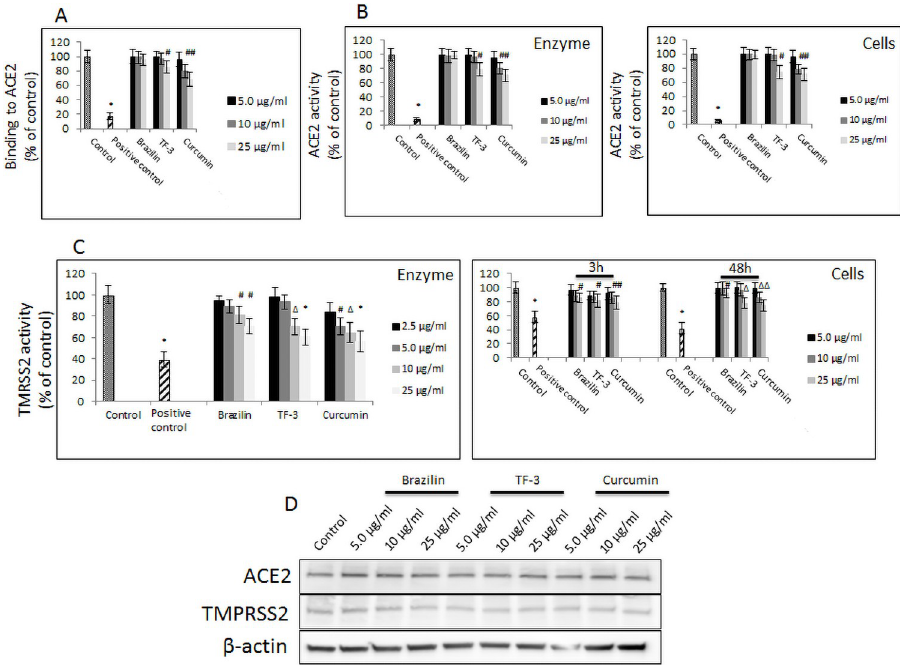
Fig 5. Effects of selected polyphenols on cellular membrane associated proteases. (A) Binding of indicated polyphenols at different concentrations to hACE2 receptor. Data are presented as % of control ± SD; control– 0.025% DMSO, positive control– 50% DMSO. (B) Activity of recombinant hACE2 upon treatment with indicated polyphenols at different concentrations. (left panel). Activity of cellular hACE2 upon treatment with indicated polyphenols at different concentrations. (right panel). Data are presented as % of control ± SD; � p � 0.001. Control– 0.025% DMSO, positive control– 10% DMSO. (C) Activity of recombinant TMPTSS2 upon treatment with indicated polyphenols at different. (left panel). Activity of cellular TMPTSS2 upon treatment with indicated polyphenols at different concentrations (right panel). Data are presented as % of control ± SD; # p � 0.05, Δ p � 0.01, � p � 0.001. Control– 0.025% DMSO, positive control– 50–100 μ M camostat mesylate. (D) Western blot analysis of hACE2 and TMPRSS2 expression in A549 cells upon treatment with indicated polyphenols with different concentration for 48h period. Data are presented as % of control ± SD; control– 0.025% DMSO, TF-3 –theaflavin-3,3’-digallate.